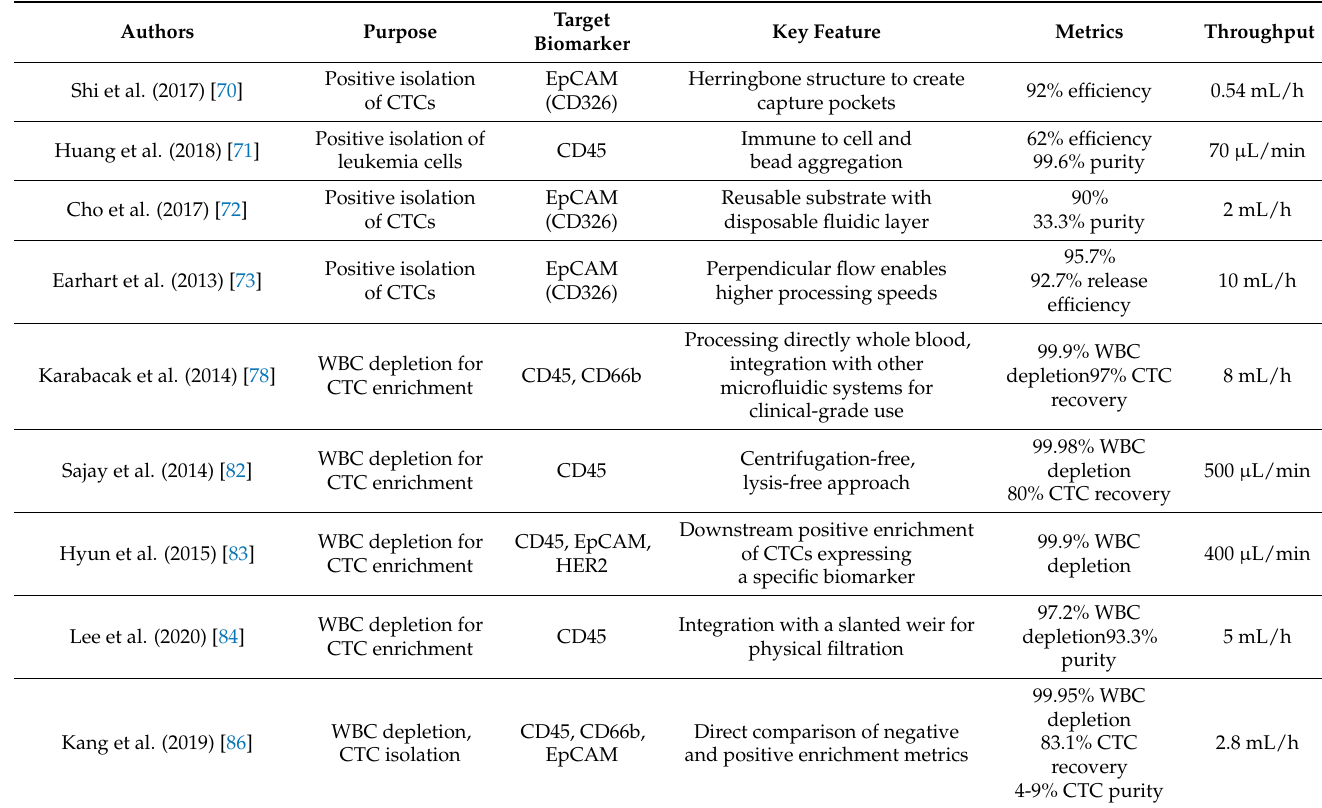
Table 2. Summary of the recent magnetophoretic positive and negative enrichment of